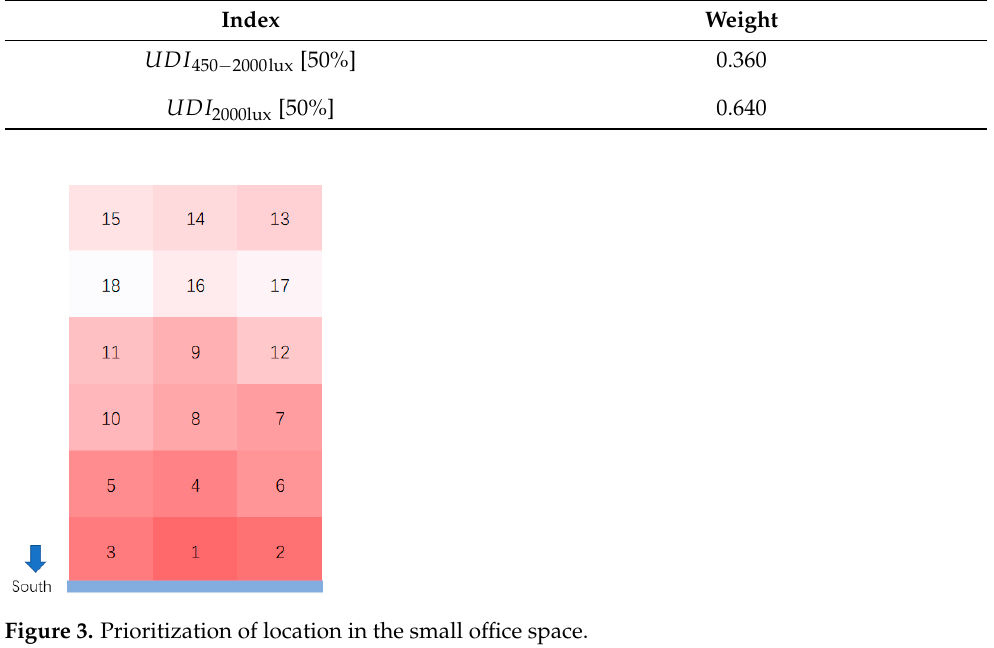
Table 6. The weights of UDI 450 − 2000lux [ 50% ] and UDI 2000lux [50%] in the small office space.